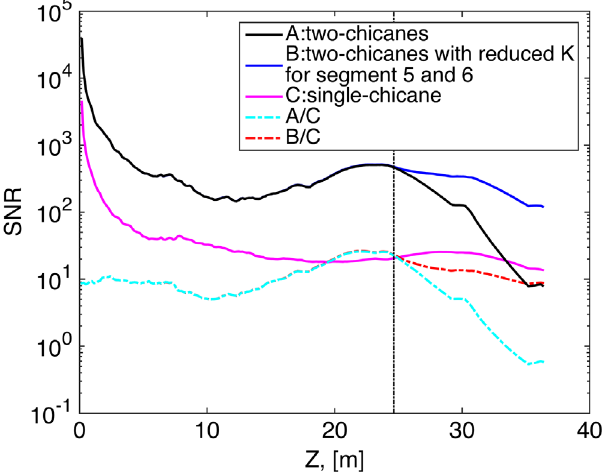
FIG. 14. Evolution of the SNR as a function of the position inside the last radiator. The vertical line indicates the point where K is changed, see